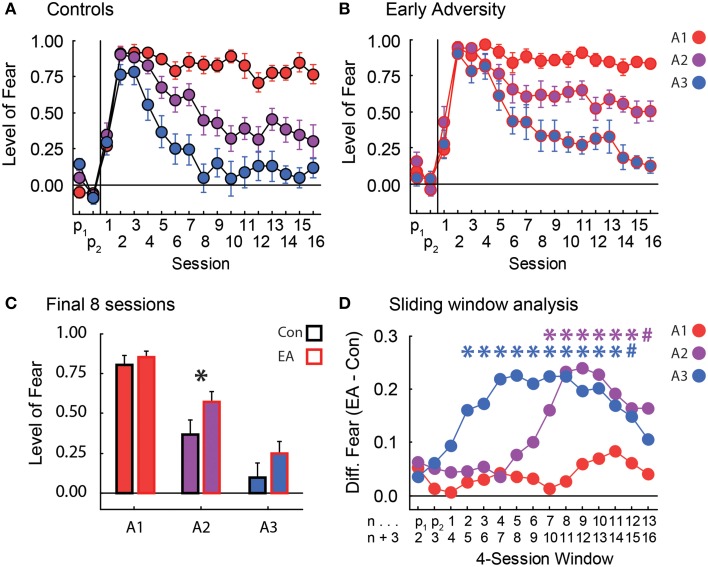
Fear in discrimination. (A) The level of fear (y-axis, suppression ratio) to the three cues [p(shock) = 1.00, red; p(shock) = 0.25, purple; and p(shock) = 0.00, blue] over the two pre-exposure sessions and the 16 Pavlovian fear conditioning sessions (x-axis) is shown for Controls. Suppression ratios are reported as mean ± SEM. (B) The level of fear during pre-exposure and Pavlovian fear conditioning is shown for Early Adversity (EA) rats. All graph properties maintained from (A). (C) The mean ± SEM suppression ratio to each cue (colors maintained from A and B) for Control (black outline) and EA rats (red outline) is shown for the last 8 sessions of discrimination. The asterisk indicates a significant difference between Control and EA rats (two-tailed t-test, p < 0.05). (D) Starting on the first pre-exposure session, we used a four-session sliding window analysis (n → n + 3) to calculate the difference in suppression ratios between EA and Control (Con) rats (y-axis, EA–Con). This difference was plotted for each cue [p(shock) = 1.00, red; p(shock) = 0.25, purple; and p(shock) = 0.00, blue]. A larger number indicates more fear to that cue by EA rats compared to Controls. The first (n) and last (n + 3) sessions of each four-session window are labeled on the x-axis beneath their corresponding data points. For every cue in each window, we tested the significance of the difference between EA and Con rats using a one-tailed, independent sample t-test. Asterisks indicate significance (one-tailed t-test, p < 0.05), and their colors denote the cue being compared. Blue # sign, p = 0.068. Purple # sign, p = 0.058.